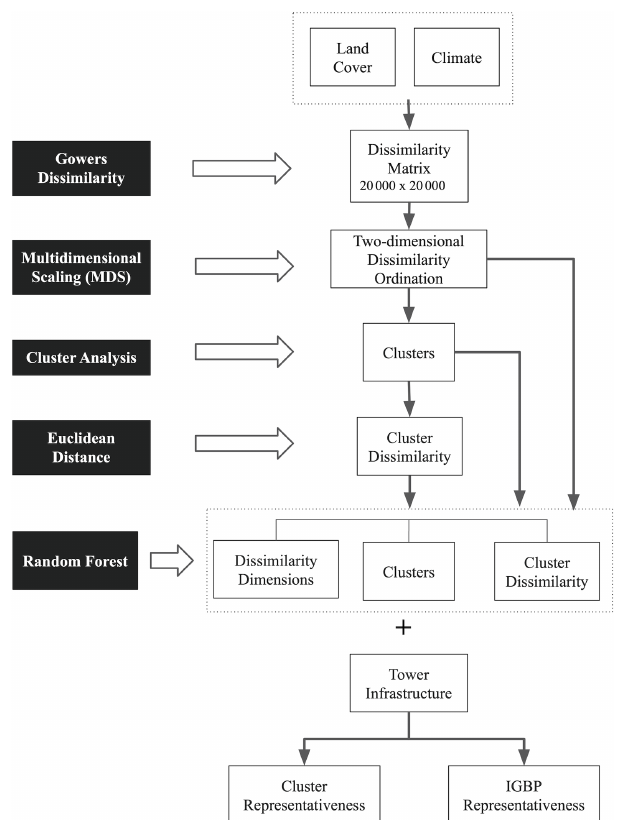
Figure 1. To determine the gaps in physical research infrastructure for CH 4 fluxes we measured landscape cover and climate dissimi- larity across the US and evaluated the current distribution of CH 4 tower infrastructure.